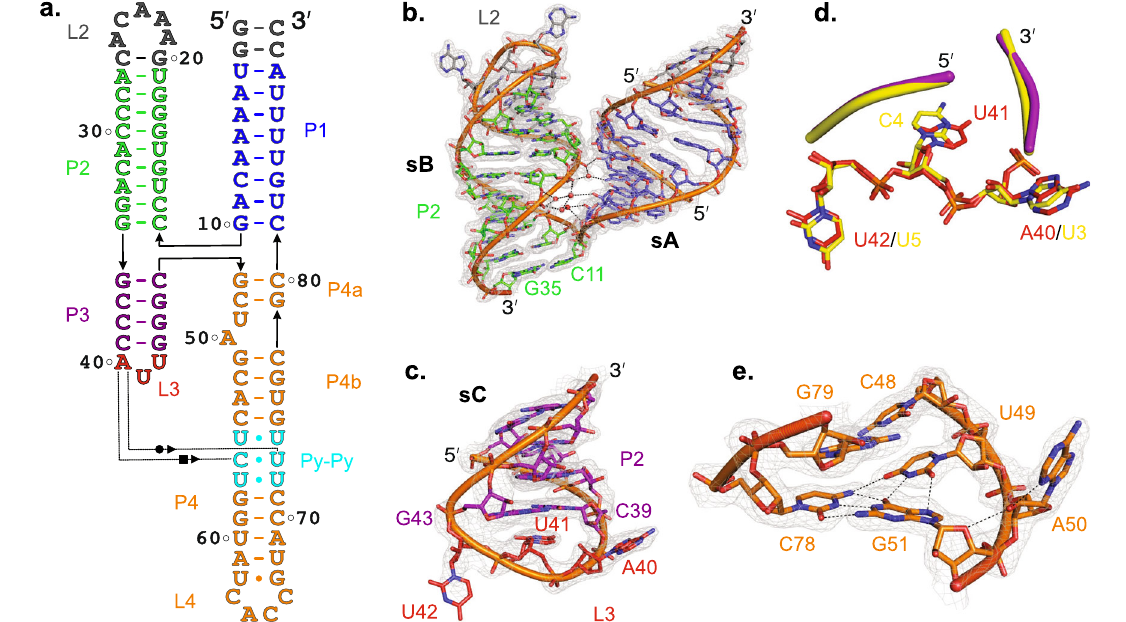
Fig. 2 | Structural features of the CVB3 5 ′ CL subdomains. a The crystal-derived secondarystructureoftheCVB35 ′ CL2aconstruct.Thedottedlineindicatestertiary interactions between the L3 loop A40 and the P4 helix Py-Py region. b The tertiary interactions between the sA and sB subdomains. c Structure of the trinucleotide loop within the sC subdomain. d Superposition of the 5 ′ -ccAUUgg-3 ′ and the 5 ′ - ccUCUgg-3 ′ stem-loops(RMSD=0.44Å)fromthecrystalstructuresofCVB35 ′ CL2a